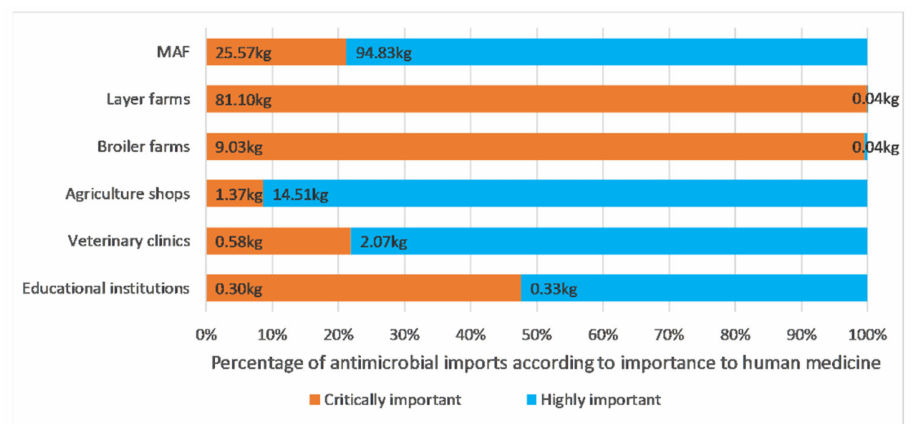
Figure 5. Profile of antimicrobial imports of different importer types by WHO classification of importance to human medicine. Important antimicrobials for human medicine represented less than 0.02 kg (0.01%) of total imports and were therefore not included in the diagram.